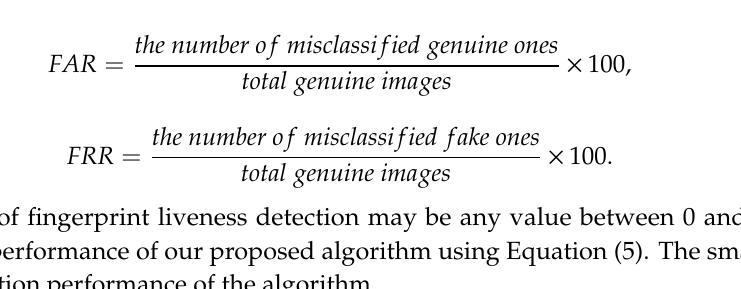
Figure 5. Parameter optimization figures under different feature fusion operation in the LivDet 2015 dataset from Hi_Scan: ( a ) addition operation; ( b ) maximum operation; ( c ) minimum operation; ( d ) average operation; ( e ) concatenation operation. 4.2. Classification Accuracy Discussion